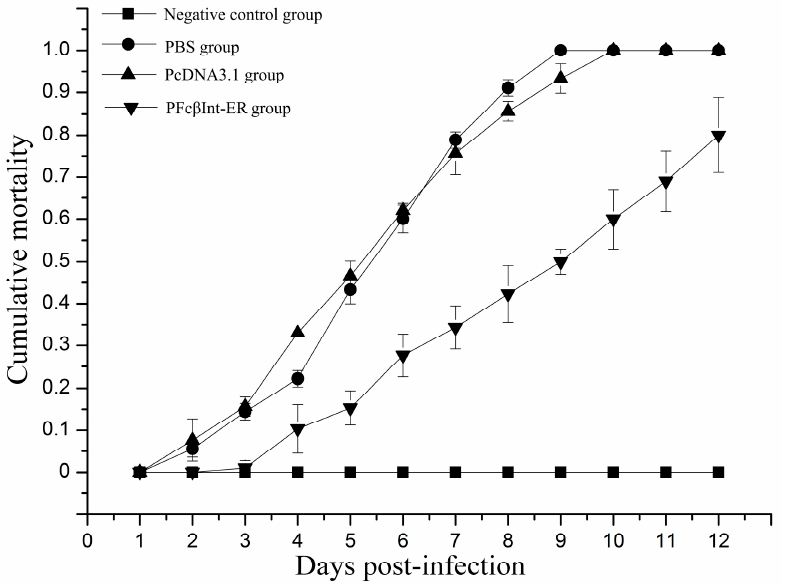
Figure 5. In vivo neutralization assay of WSSV infection with PFc β Int-ER. All groups challenged with WSSV 10 5 virions per shrimp and their mortalities were recorded for 12 days. Shrimp were treated with PBS as a control. The bar represents the SD of the mean ( n = 3).